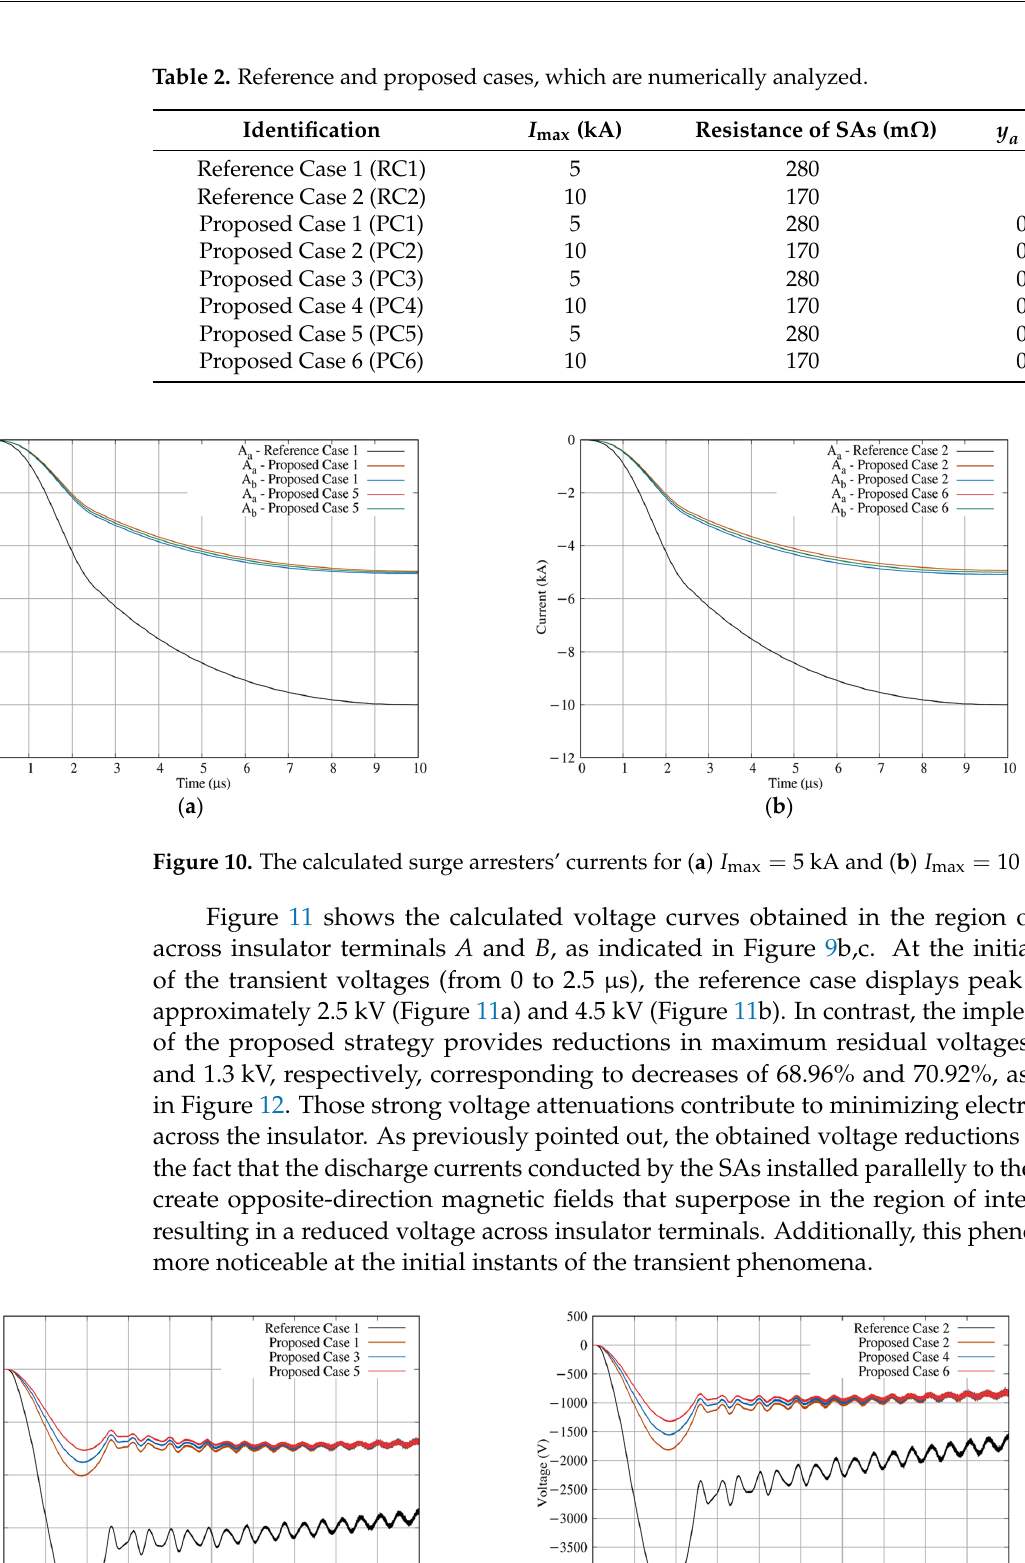
Figure 11. Residual voltages calculated in the region of insulator installation considering: ( a ) I s = 5 kA and ( b ) I s = 10